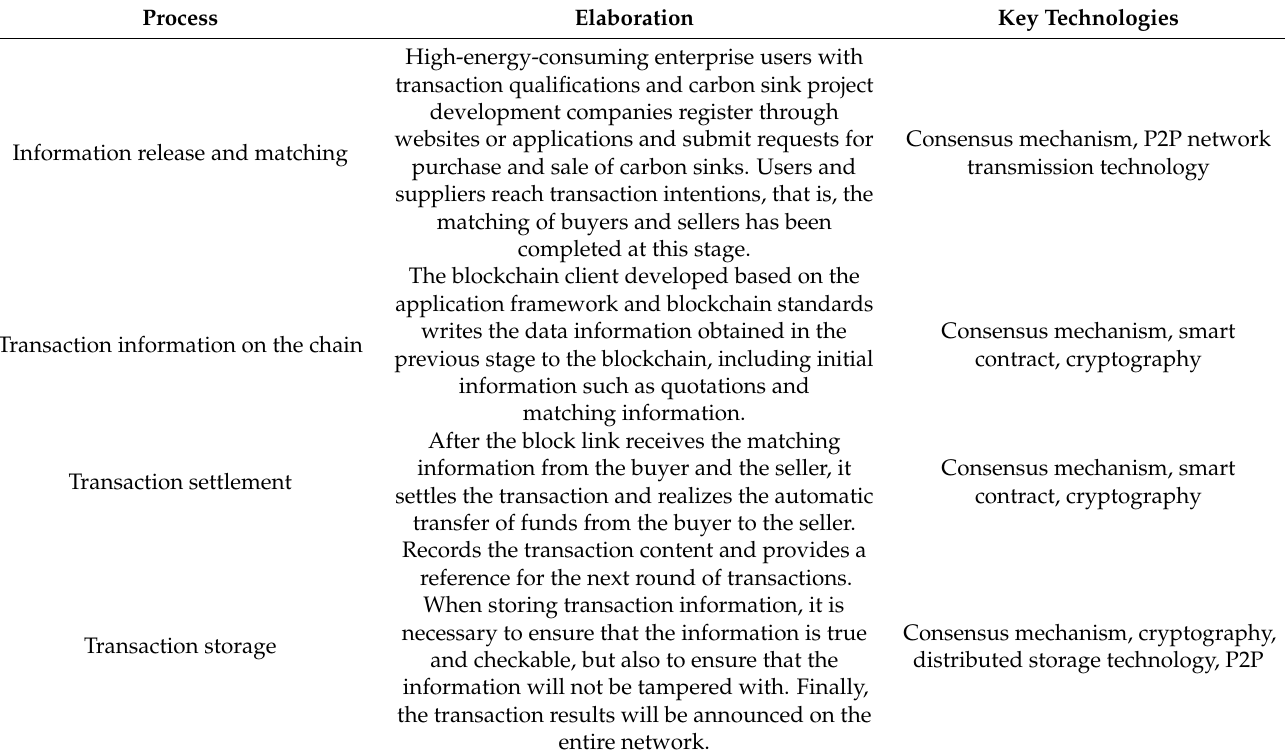
Table 2. On-chain blue carbon trading process and key technologies.